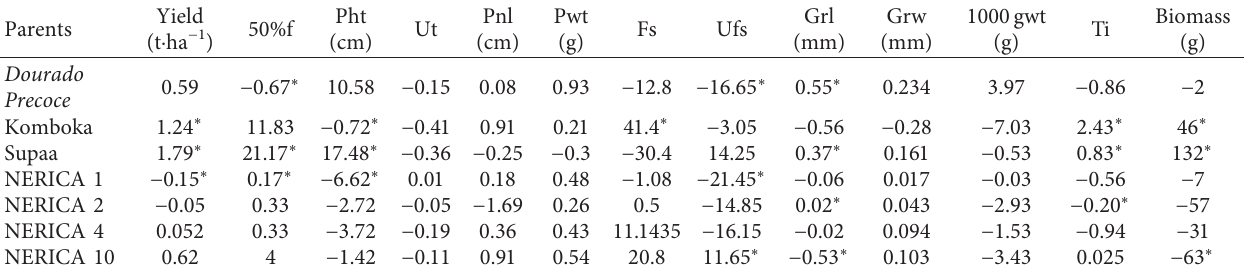
Table 3: General combining ability effects for parents at KALRO, Mtwapa, and Bahari during the long rain season of 2018. Parents